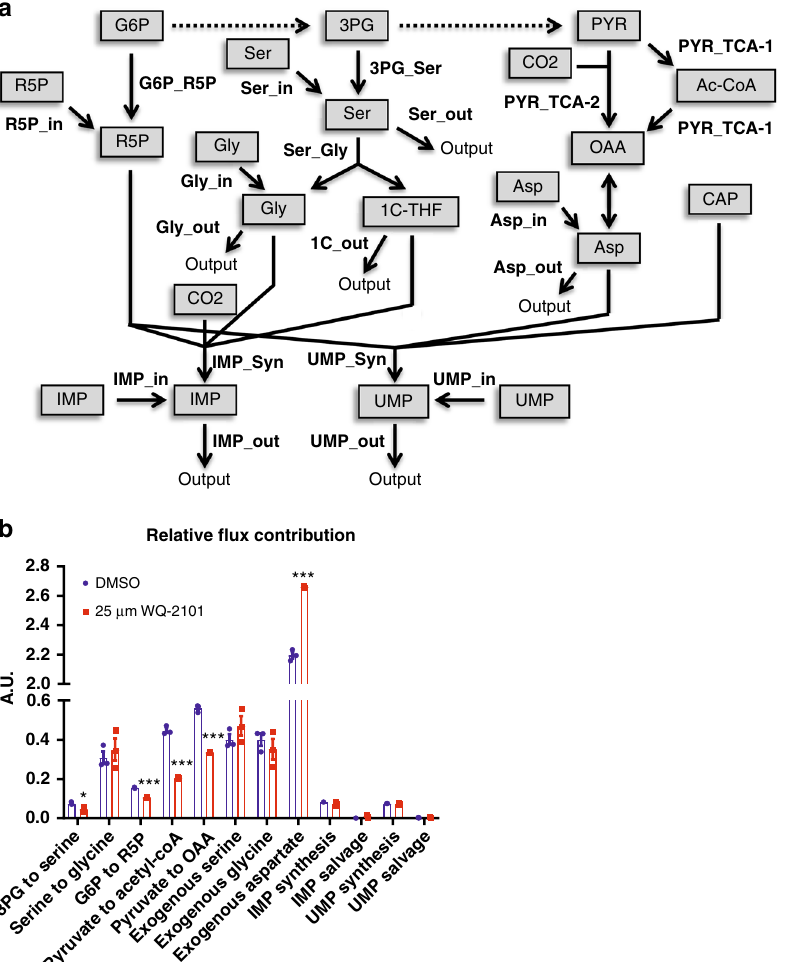
Fig. 4 Quantitative fl ux analysis reveals that PHGDH supports central carbon metabolism. a Schematic of metabolic fl ux analysis model. R5P (ribose-5- phosphate); G6P (glucose-6-phosphate); Ser (serine); Gly (glycine), 3PG (3-phosphoglycerate); CO2 (carbon dioxide); PYR (pyruvate); Ac-CoA (acetyl- coA); OAA (oxaloacetate); Asp (aspartate); CAP (carbamoyl phosphate); UMP (uridine monophosphate); IMP (inosine monophosphate). b Relative fl ux rate of metabolic pathways in cells treated with 25 μ M WQ-2101. Data are the mean of three biological replicates, and error bars represent s.e.m. P <